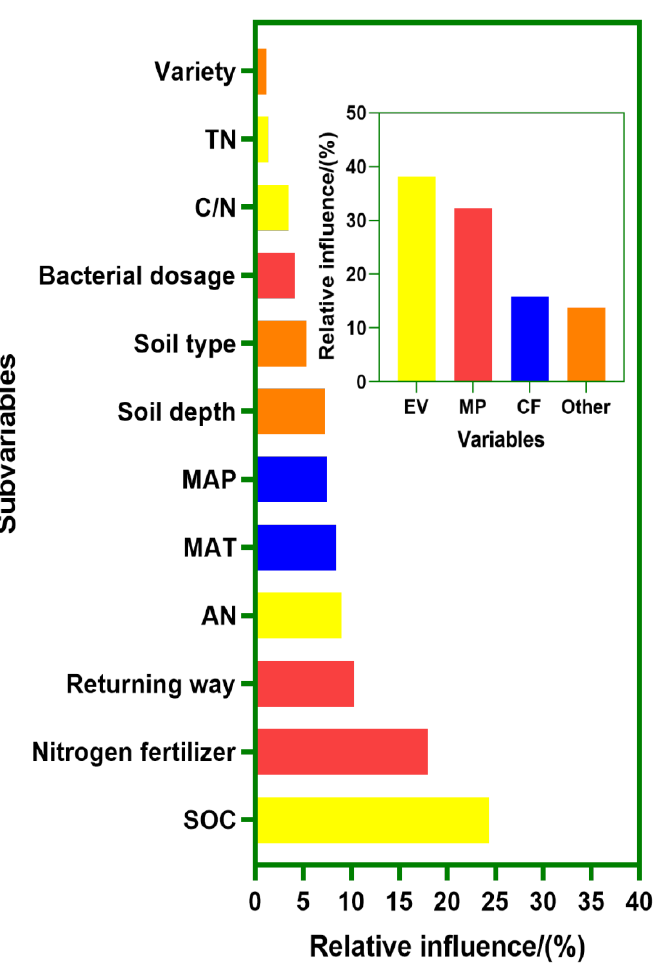
Figure 13. The relative influence (RI, %) of climate factors (CF, mean annual temperature and precipitation), edaphic variables (EV: SOC, AN, TN, and the C:N ratio), management practices (MP: N fertilizer application amounts, straw return methods, and bacterial dosage), and other factors (Other: soil depth, soil type, and variety) on rice yield in the aggregated boosted tree model analysis.